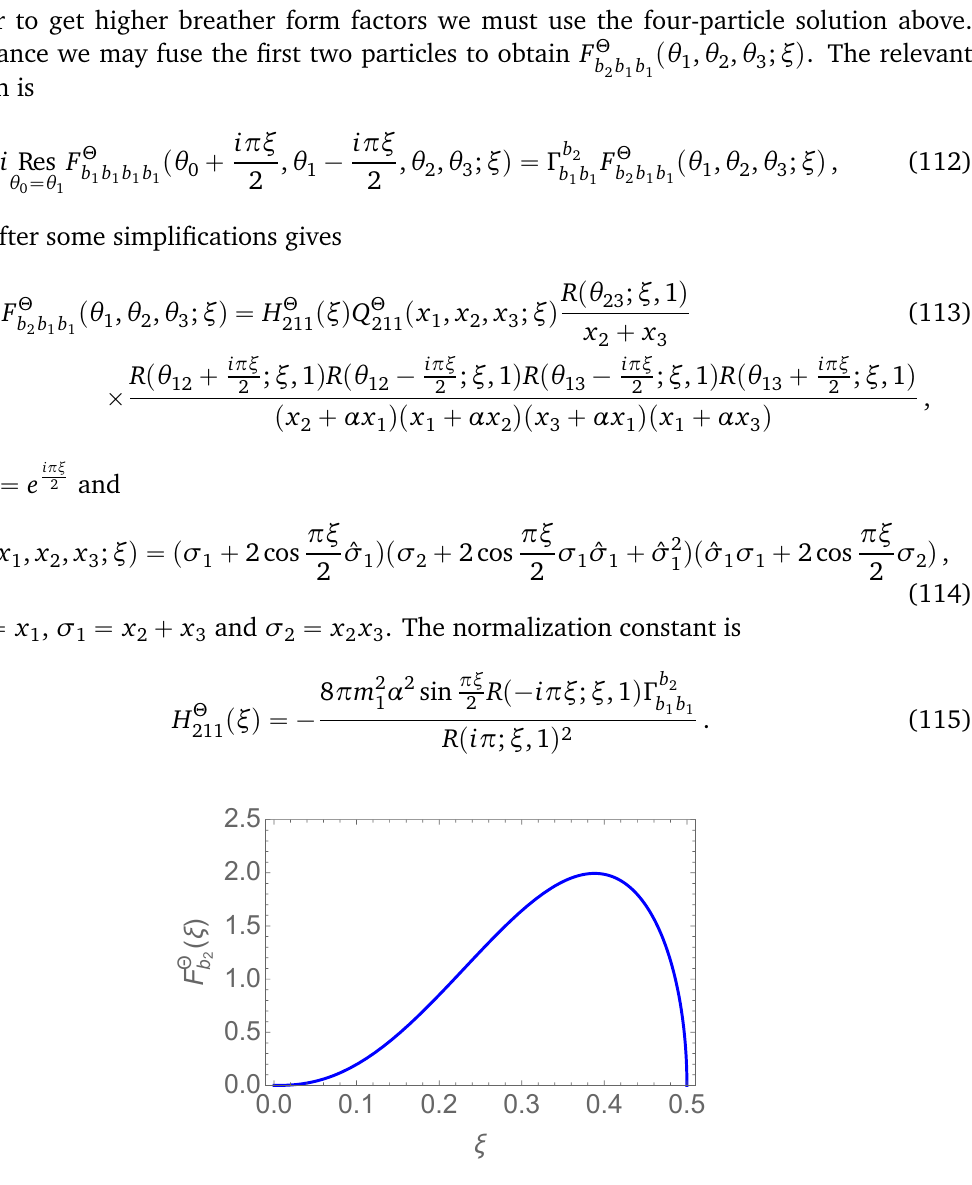
p ξ q for m “ b 2